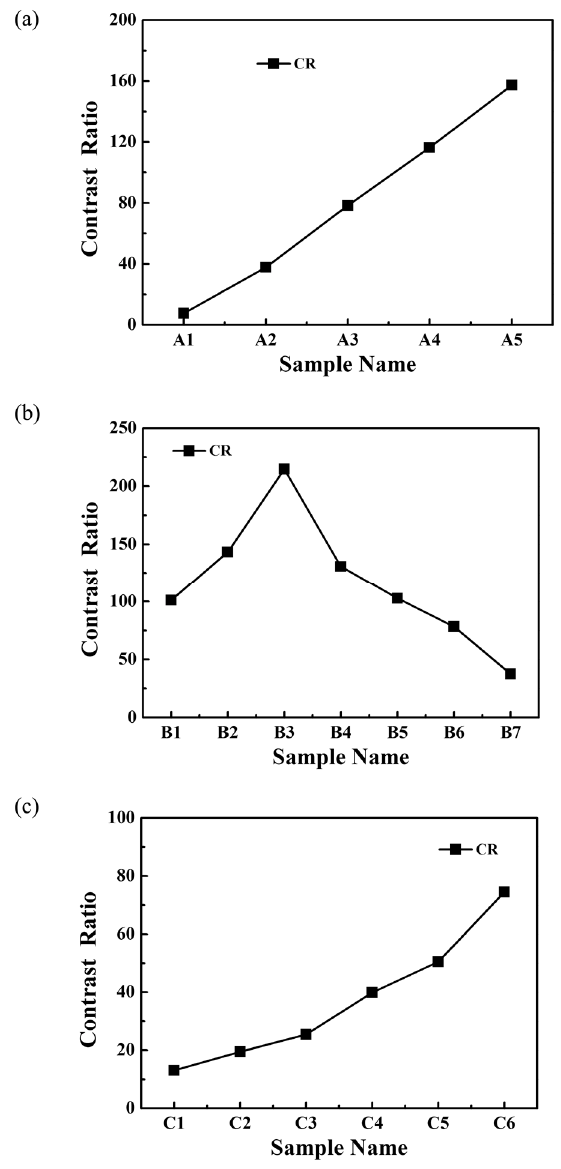
Figure 7. ( a ) The contrast ratio (CR) of samples A1 – A5 ; ( b ) the contrast ratio (CR) of samples B1 – B7 ; ( c ) the contrast ratio (CR) of samples C1 – C6 .